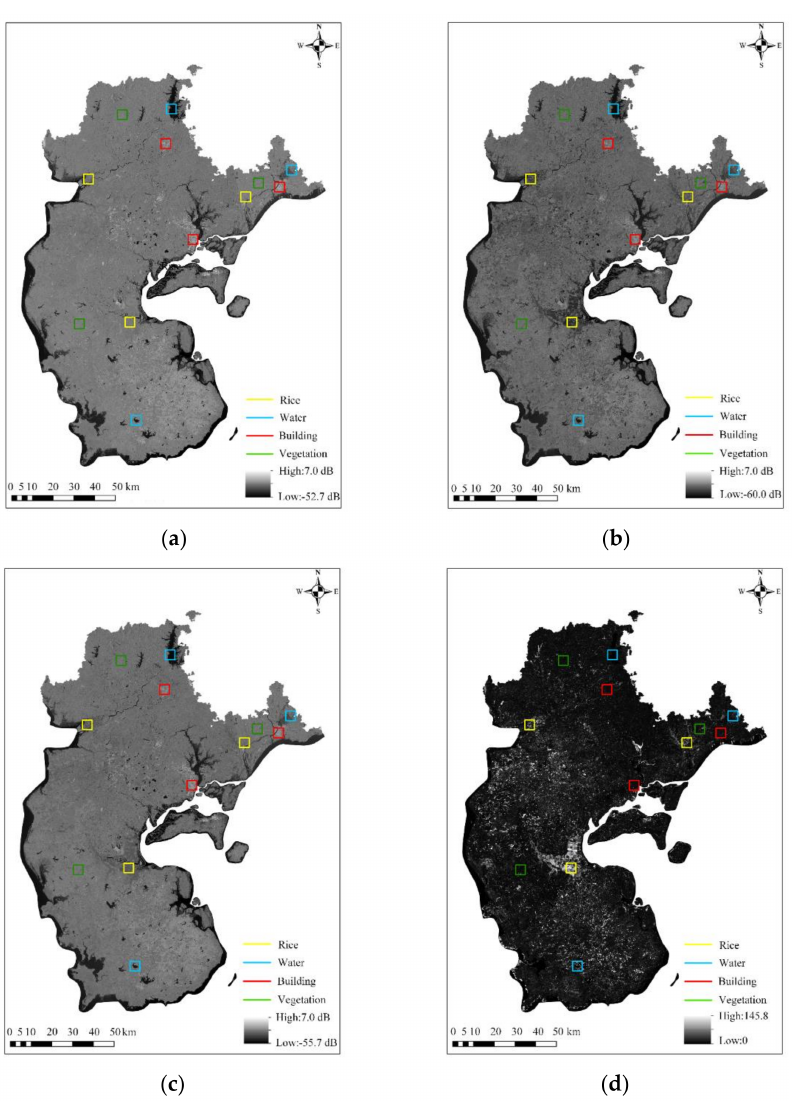
Figure 5. Time series statistical parameter diagram. ( a ) Maximum; ( b ) minimum; ( c ) average; ( d )